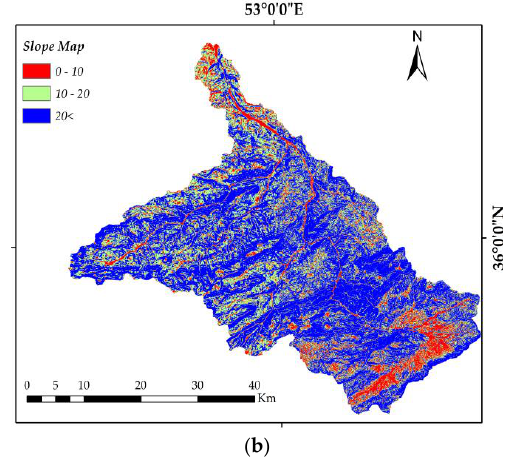
Figure 2. ( a ) Land use and ( b ) slope (%) of the Talar River Basin.